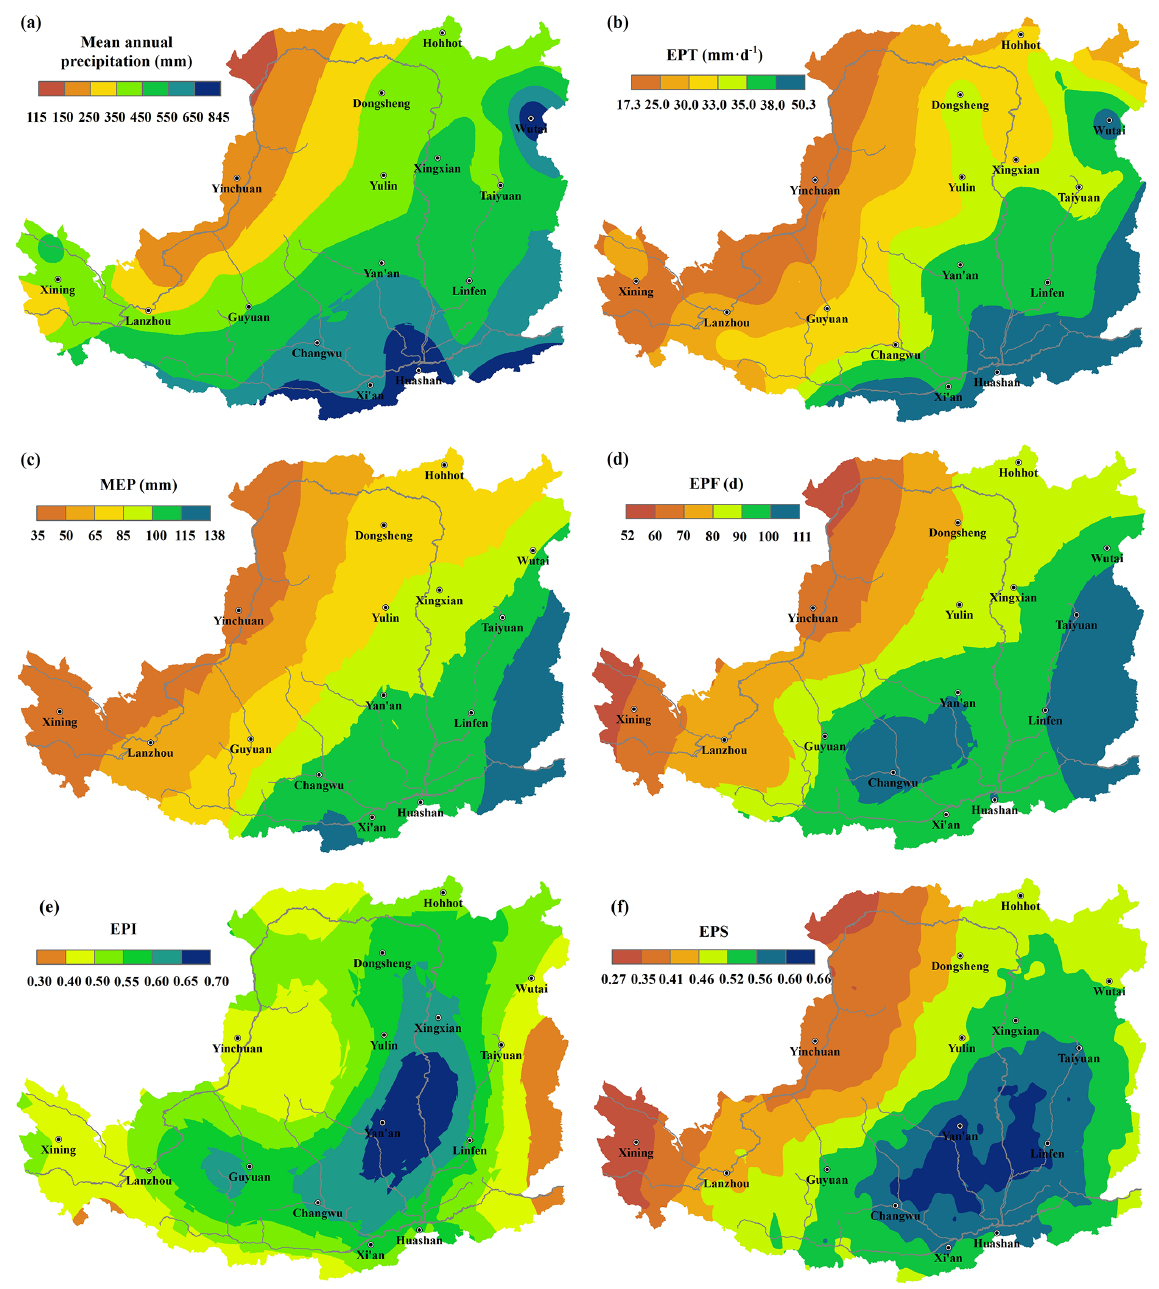
Figure 3. Spatial distributions of (a) mean annual precipitation, (b) EPTs, (c) MEP, (d) total EPF, (e) mean EPI, and (f) mean annual EPS in the LP from 1961 to